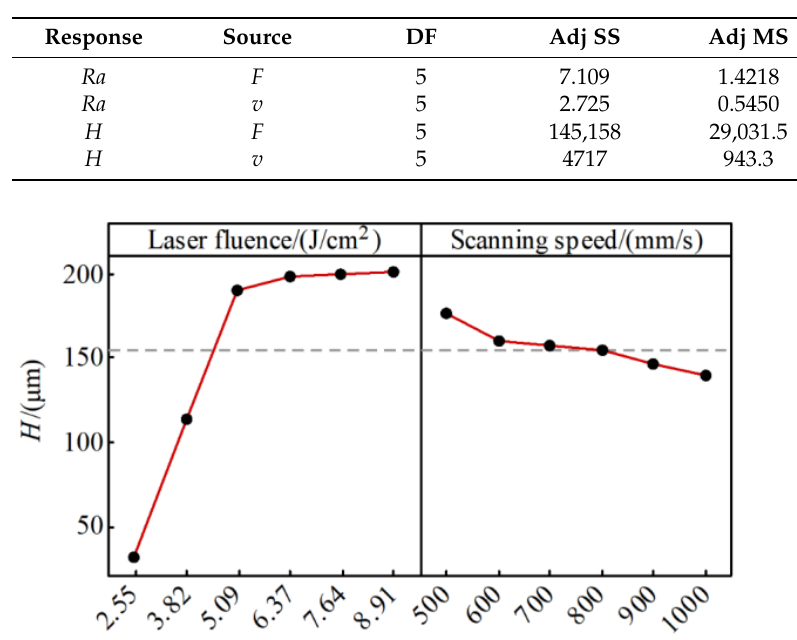
Table 4. Analysis of variance for surface roughness and stripping thickness.